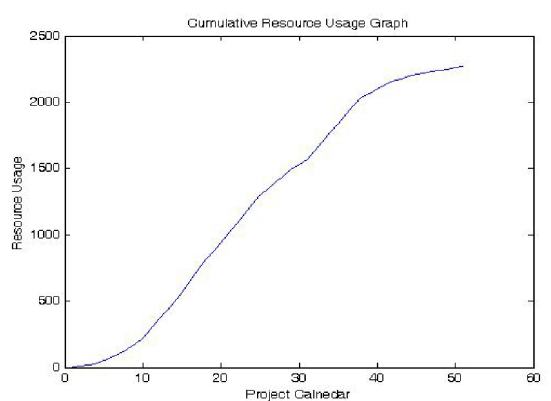
Figure 39. Cumulative resource usage for resource 1 of experiment 3 (after using forward method)